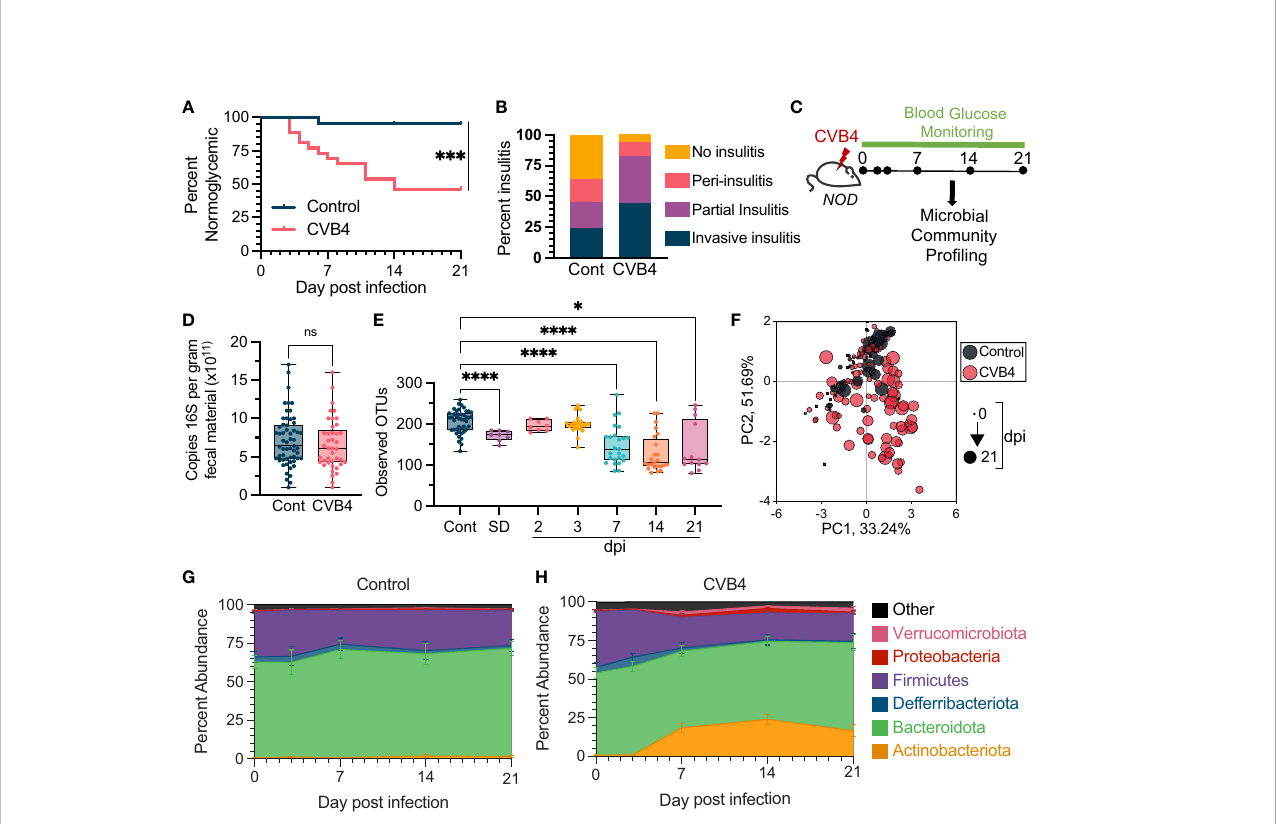
FIGURE 1 Microbial Dysbiosis is a Consequence of Coxsackievirus B4 (CVB4) Infection (A) Diabetes incidence in uninfected control (n = 20) vs. CVB4-infected (n = 26) mice as determined by blood glucose measurement. Data are combined from 3 independent experiments and analyzed using a log-rank (Mantel-Cox) test. (B) Degree of pancreatic insulitis as (at day 21 pi) determined by histology (n = 5-6 per group). (C) Timeline of microbial community pro fi ling. Fecal samples were collected at days 0, 2, 3, 7, 14, and 21 days pi. (D) Copies of 168 genes per gram offecal material as measured by qPCR (CVB4 = days 2-21 pi). P value calculated using paired Welch's t test (two-tailed). (E) a-diversity (Observed number of OTUs) in bacterial communities following CVB4 infection. Control group includes baseline samples from all mice in the experiment on day 0 prior to mock or CVB4 infection. P values were calculated using Welch's ANOVA with Dunnet's T3 multiple comparisons test. (F) Principal component analysis (PCoA) of microbial community compositions. Longitudinal changes in the microbiome of (G) uninfected control (n=20) and (H) CVB4-infected mice (n=26) at the phylum level throughout sampling (Days 0, 3, 7, 14, and 21 pi). Data include replicates from at least three independent experiments. Results in D and E are represented as mean ± range, G and H are mean ± standard error. *P ≤ 0.05 was considered statistically signi fi cant; ***P ≤ 0.001; ****P ≤ 0.0001, ns, not signi fi